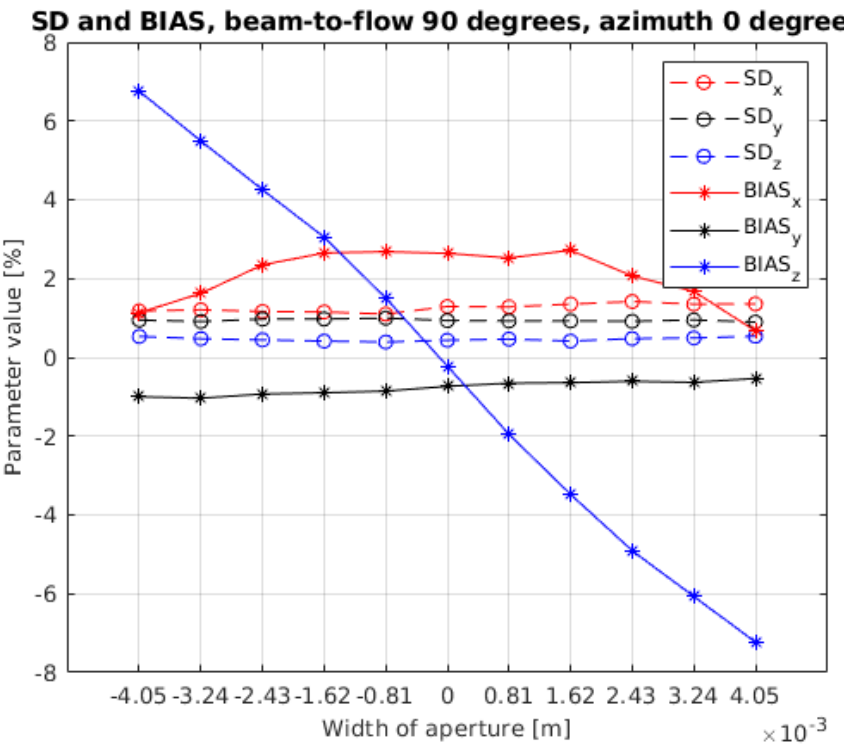
Figure 8. RSD and RB for 90 degrees beam-to-flow angle and 0 degrees rotation angle, all cross planes along the vessel. The dashed lines show the relative standard deviation, the solid lines show the relative bias. The red color is v x , the black is v y and the blue is v z components of the flow.